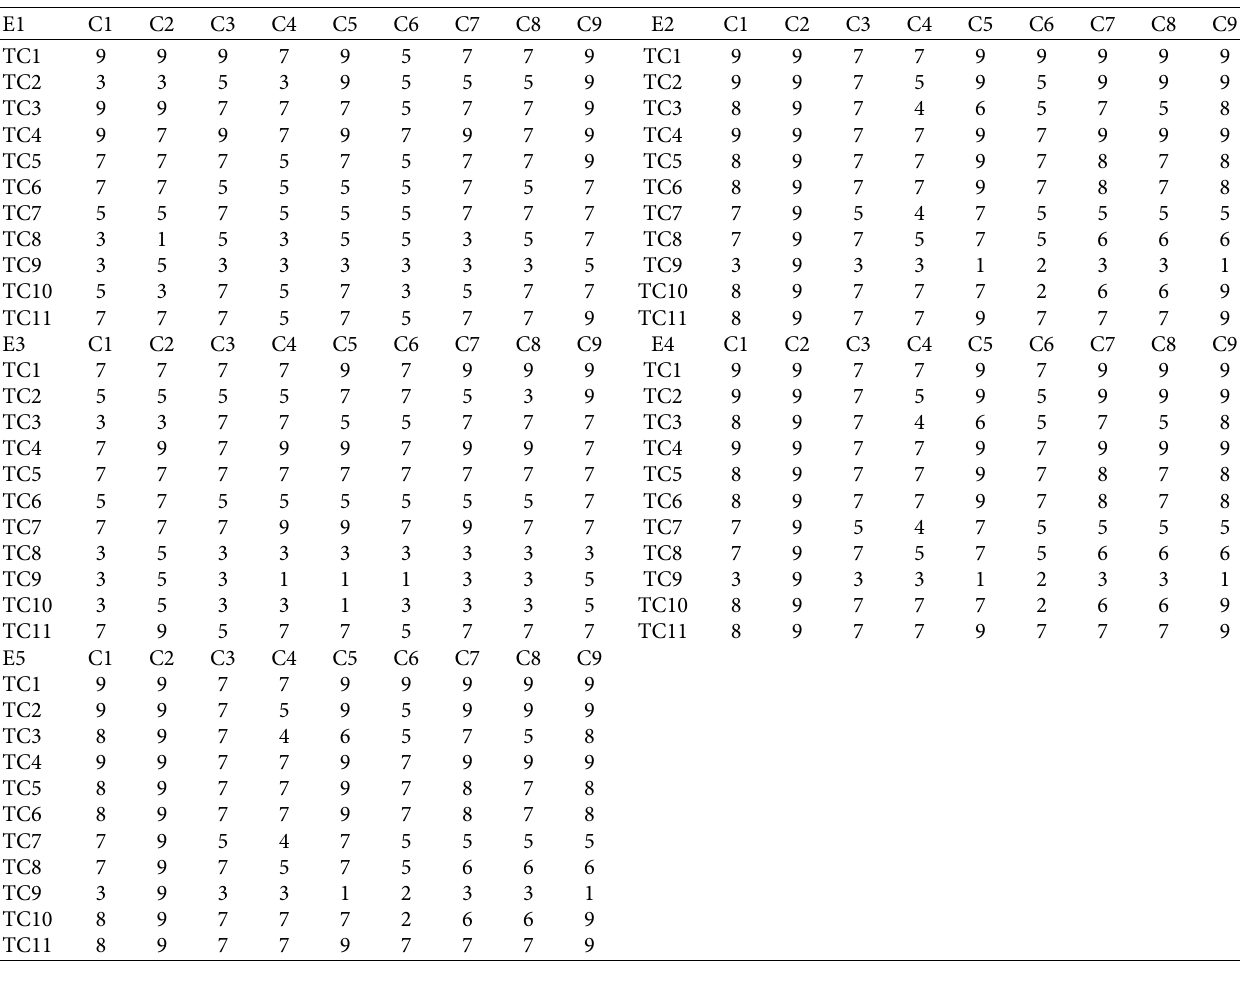
Table 8: Evaluation of companies for transporting dangerous goods by all five